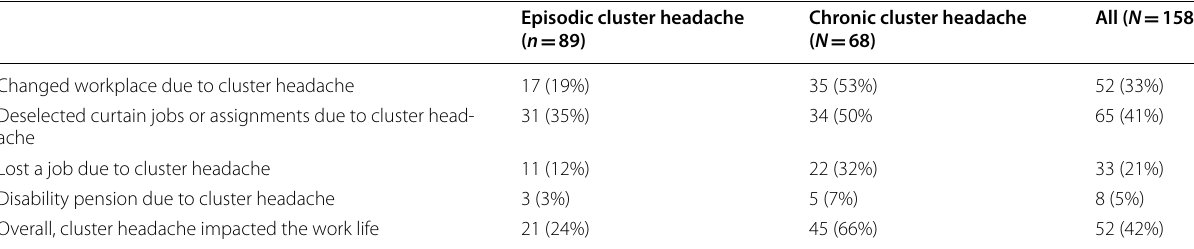
Table 2 Cluster headache impact on professional life first ten years after debut